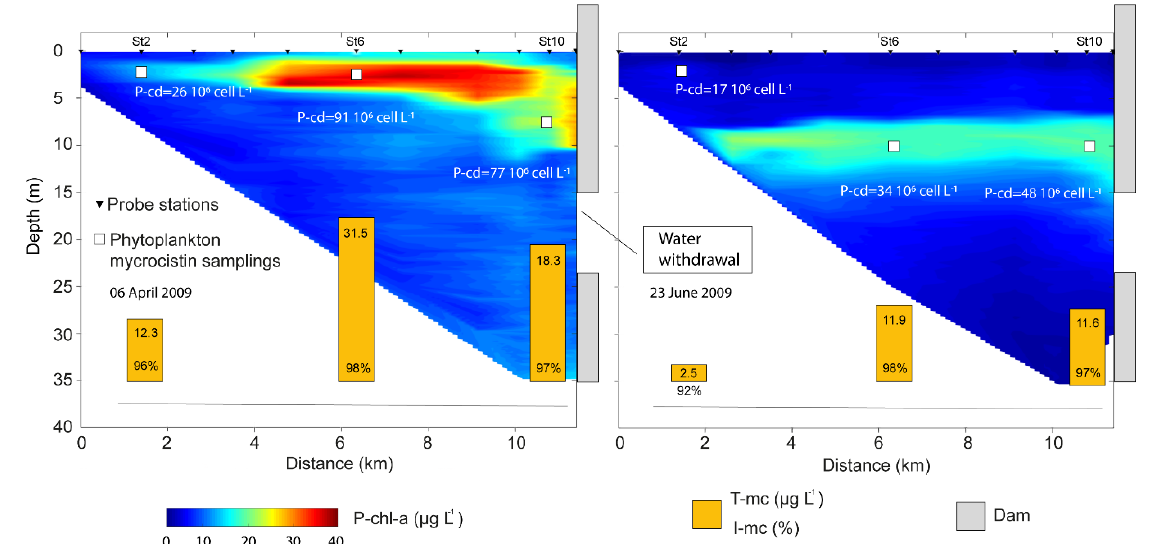
Figure 3. Contours show the distribution of the P. rubescens chl-a (P-chl-a, µg L − 1 ) concentrations over the south–north transect on 6 April 2009 (left panel) and on 26 June 2009 (right panel), with indication of the P. rubescens cell density (P-cd, cell L − 1 ) at the P-chl-a peak in stations St2, St6, and St10. Bars indicate total microcystin (T-mc, µg L − 1 ) concentrations and the percentage of intracellular microcystins (I-mc, %) at the peak of P-chl-a. Microcystin and cell density samples were collected at the depths of 2, 2.5, and 7 m on 6 April 2009 and 2.5, 10, and 10 m on 26 June 2009, at station St2, St6, and St10.